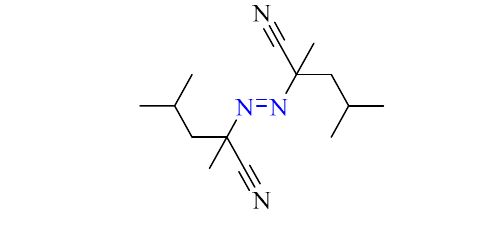
Figure 1. Chemical structure of ADVN.